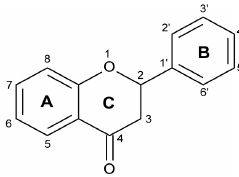
Figure 1. General structure of flavonoids.